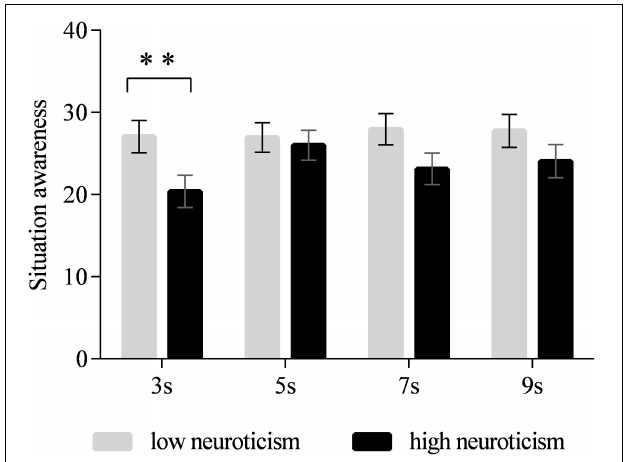
FIGURE 8 | Situation awareness for drivers with low and high neuroticism under different time intervals. (Notes. ** p < 0.01).